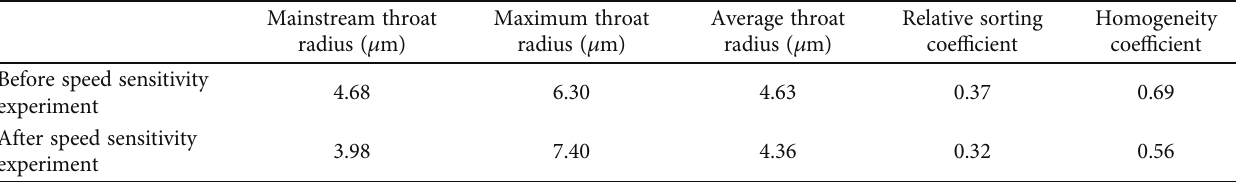
Table 6: Throat data before and after the D2 core experiment.